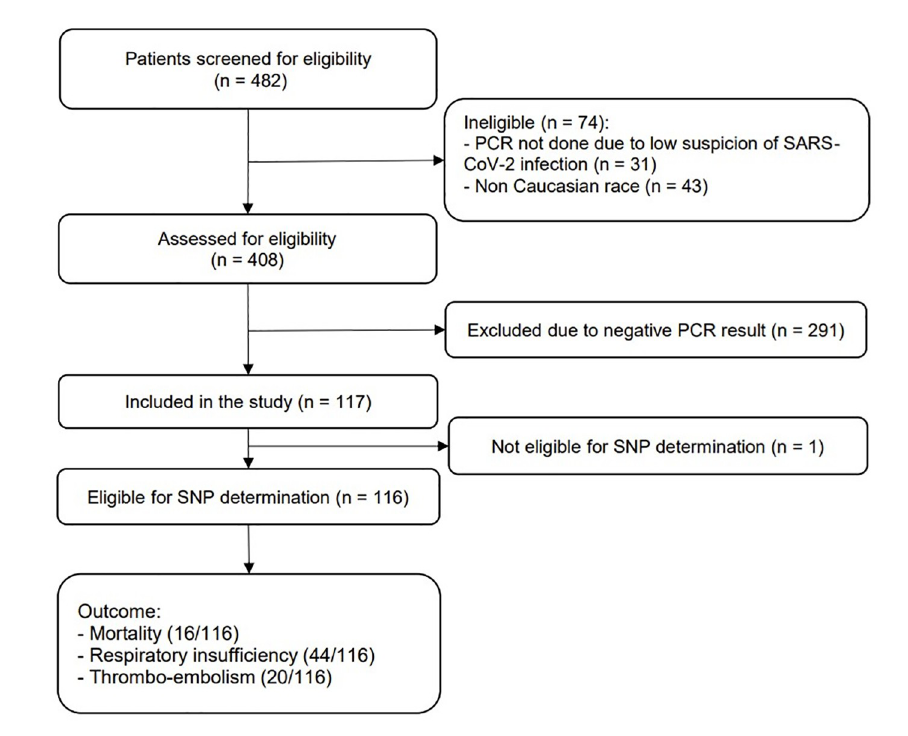
Fig 2. Flow diagram of patient